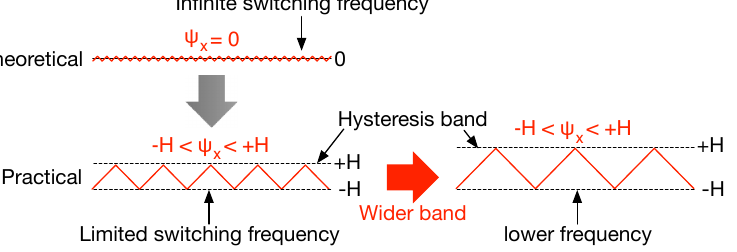
Figure 4. Practical sliding surface for limited switching